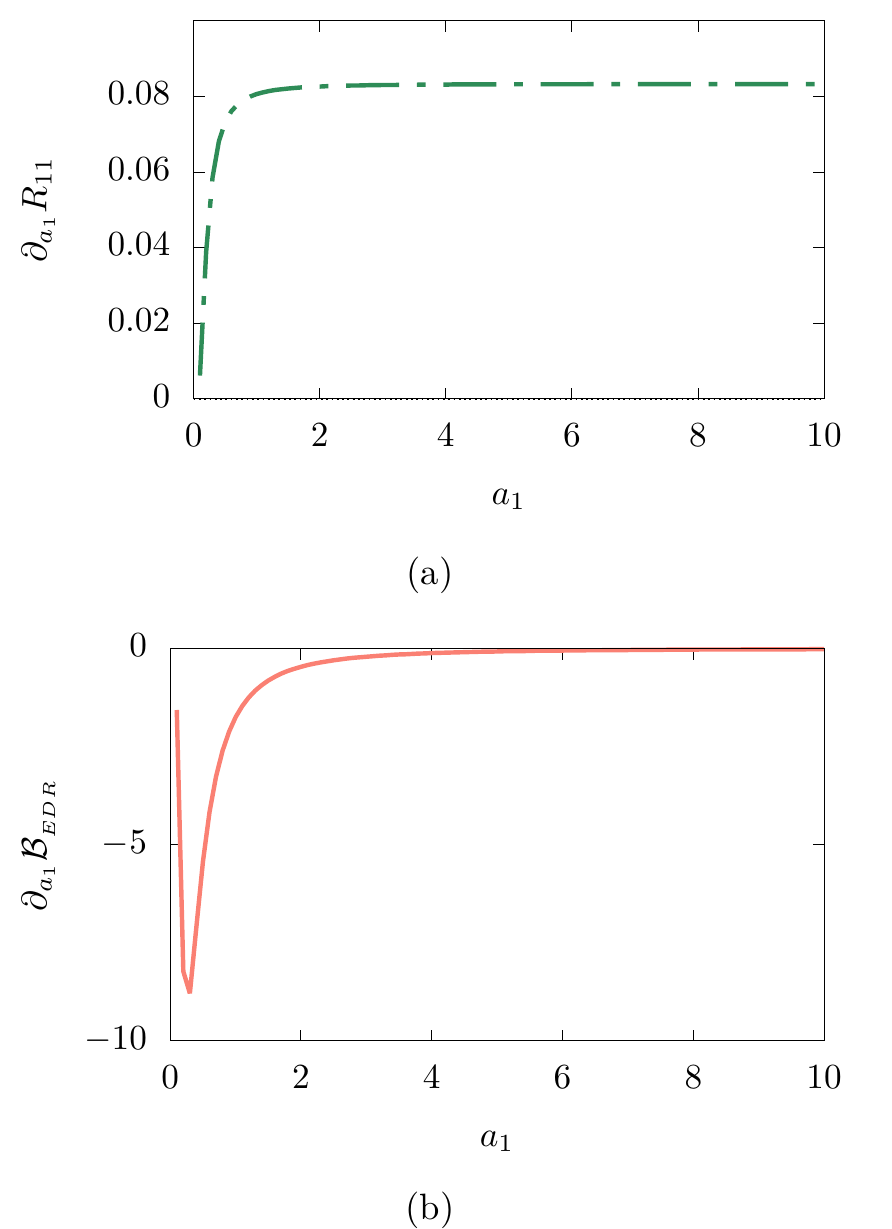
Figure 22 . (a) The derivative of the response function R 11 (∆ E ) , plotted with respect to varying acceleration a 1 for accelerated atoms in thermal background considering the Rindler modes in (1 + 3) dimensions, denoted by dash-dotted green line. (b) In this figure the quantity ∂ a corresponding to the response function is also plotted, which is denoted by the solid